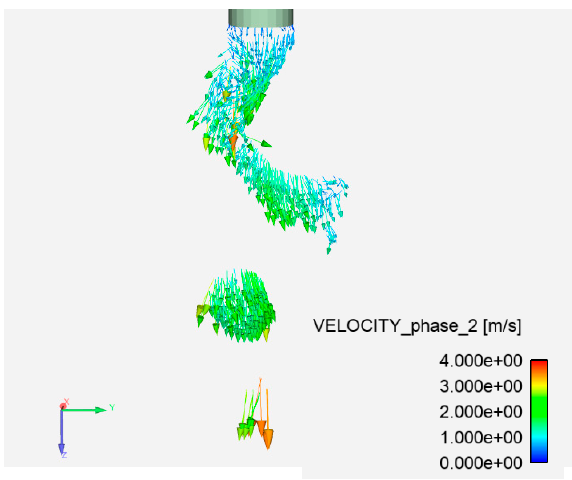
Figure 8. Droplet metal velocity vector for high-current GMAW.